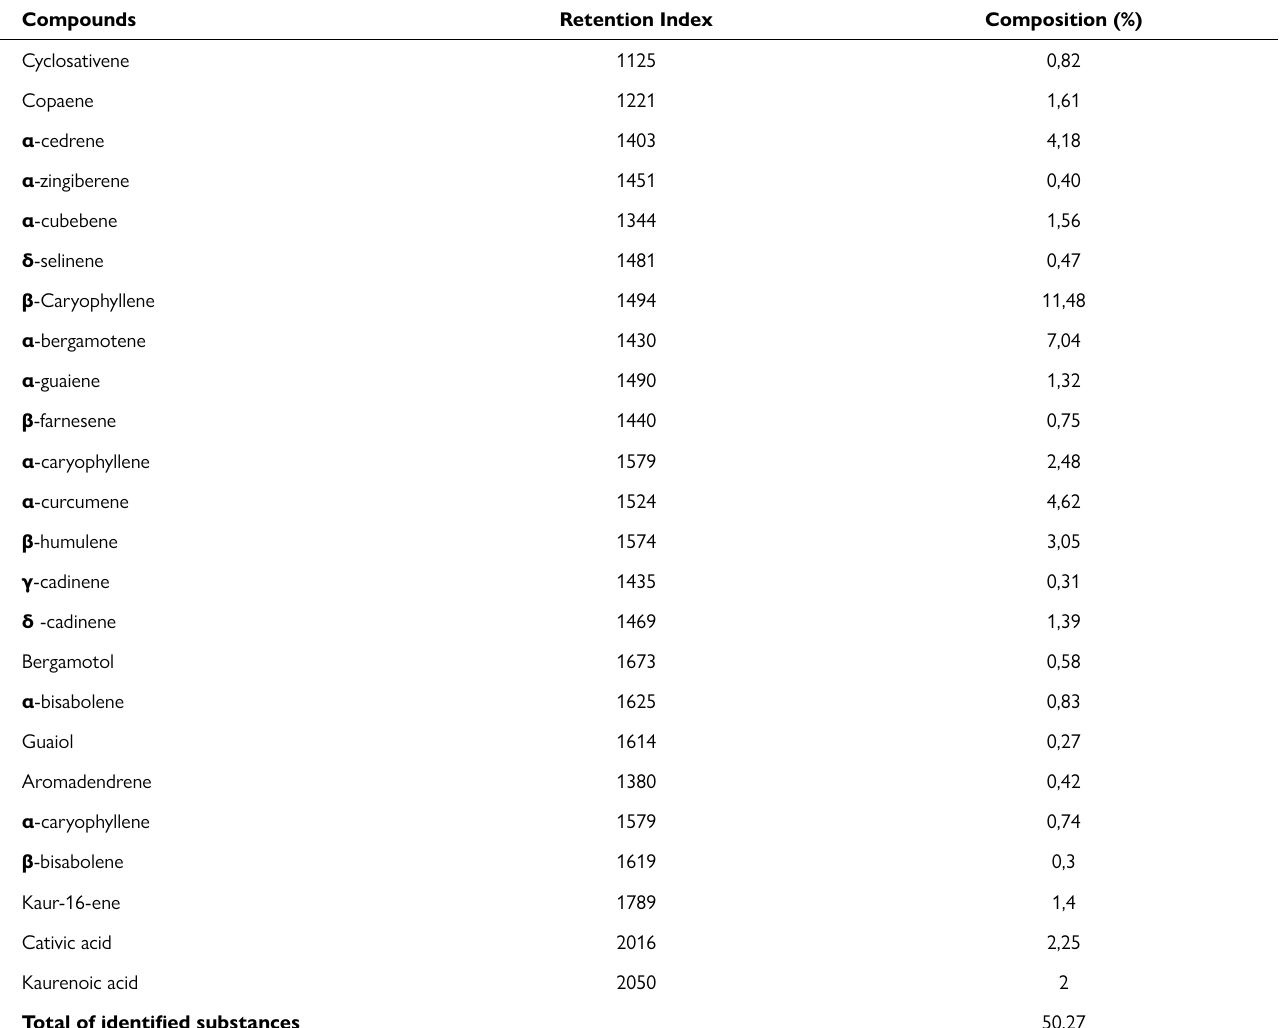
Table 1. Sesquiterpenes and Diterpenes identified in the Copaifera oleoresin, compared with the literature and fragmentation spectrum. It was possible to identify peaks of 24 compounds that represent little more than 50 % of the total composition. The major compounds found were the sesquiterpenes α-bergamotene (7.04 %) and β-caryophyllene (11.48 %). Some compounds frequently presents in copaiba oleoresins were found at 1 to 5 %, including Copaene (1.61 %), α-curcumene (4.62 %) and β-humulene (3.05 %). The major diterpenes found in the copaiba oil were Kaur-16-ene (1.4 %), kaurenoic acid (2 %) and Cativic acid (2.25